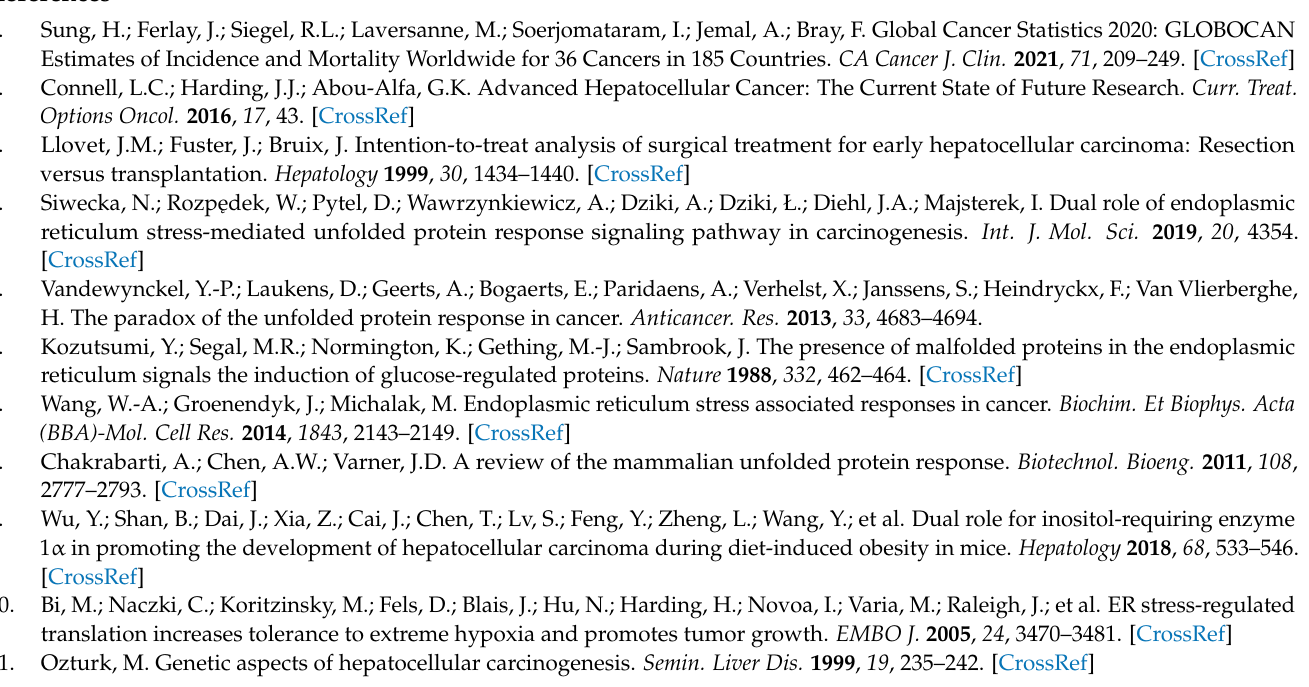
score, Table S1: Member genes of the Unfolded protein response score. Table S2: Univariate and multivariate analysis with overall survival in the TCGA cohort. Table S3: Cox regression analysis of cell proliferation-related gene sets, Table S4: List of Software used in